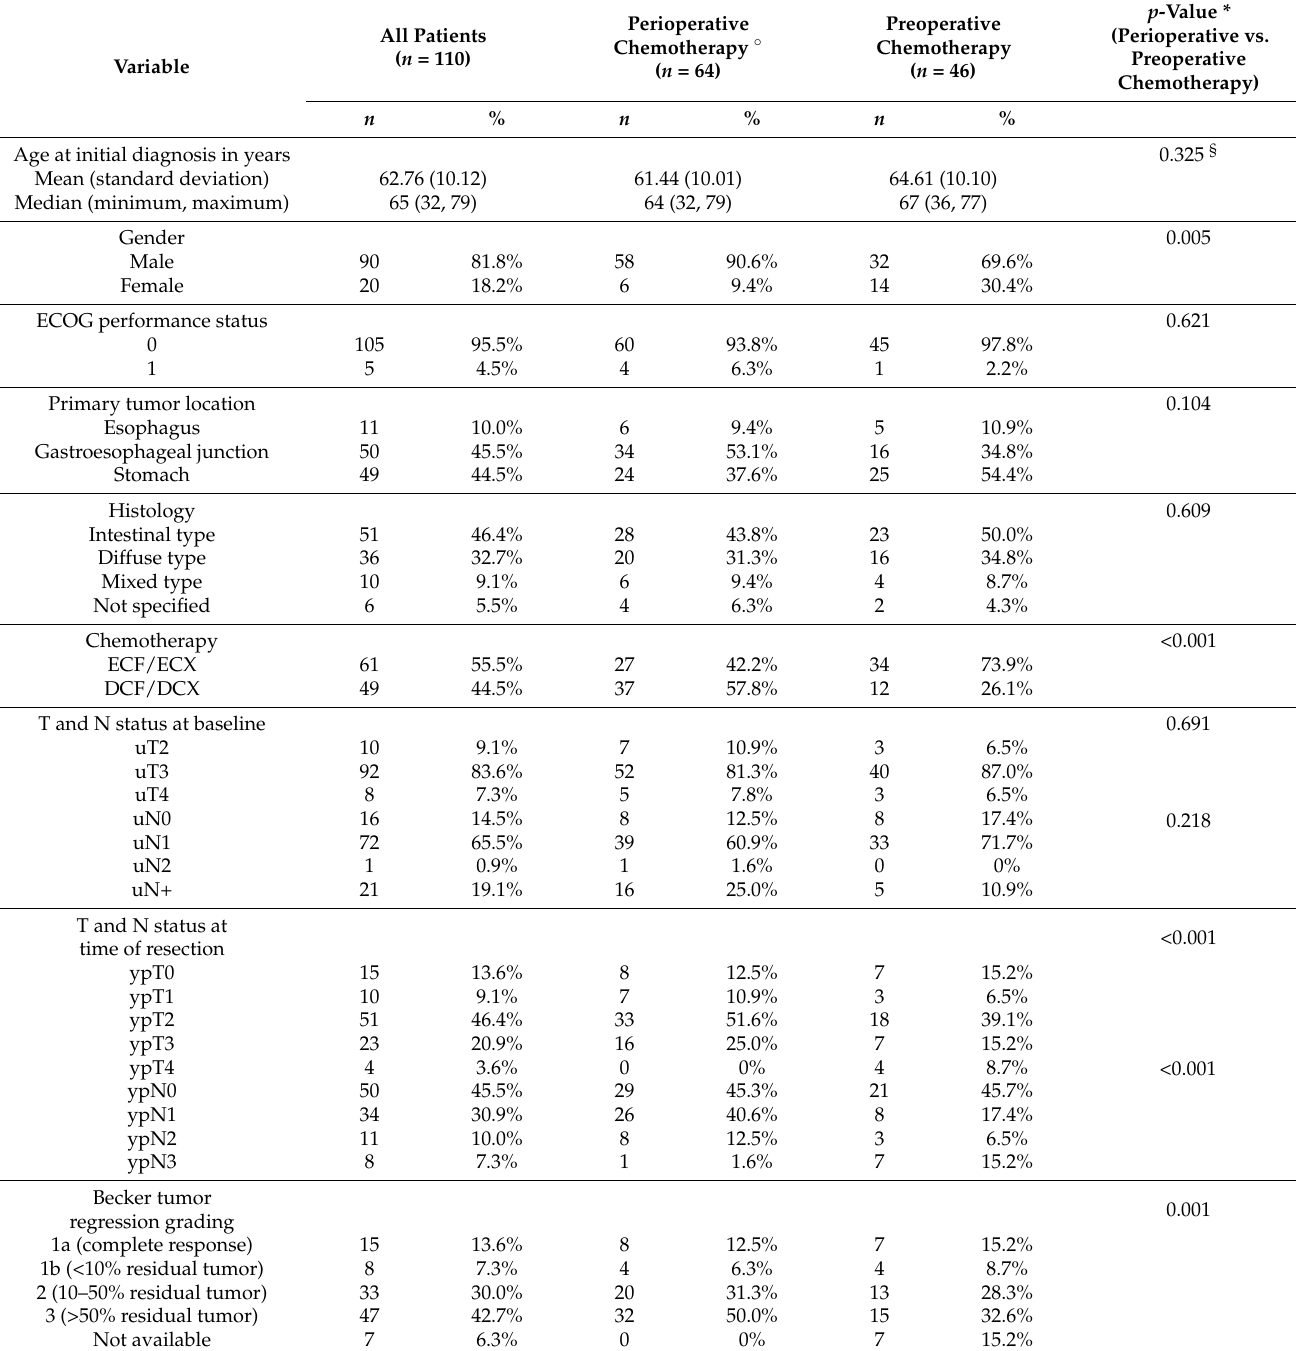
Table 1. Patient